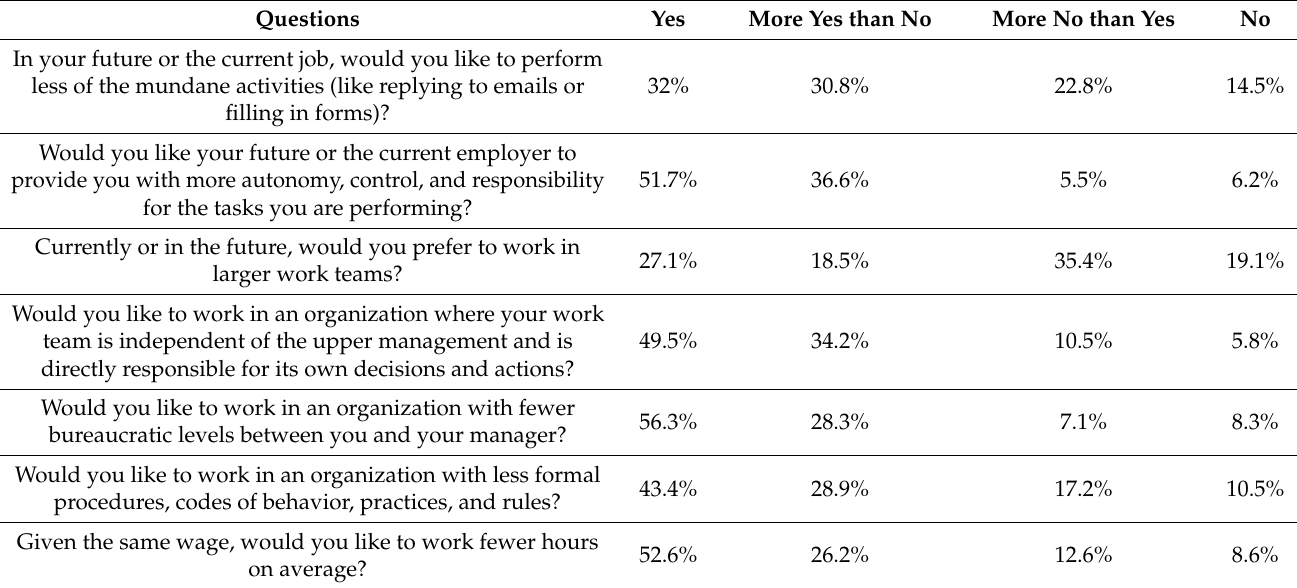
Table 2. Survey results. Hypotheses-related